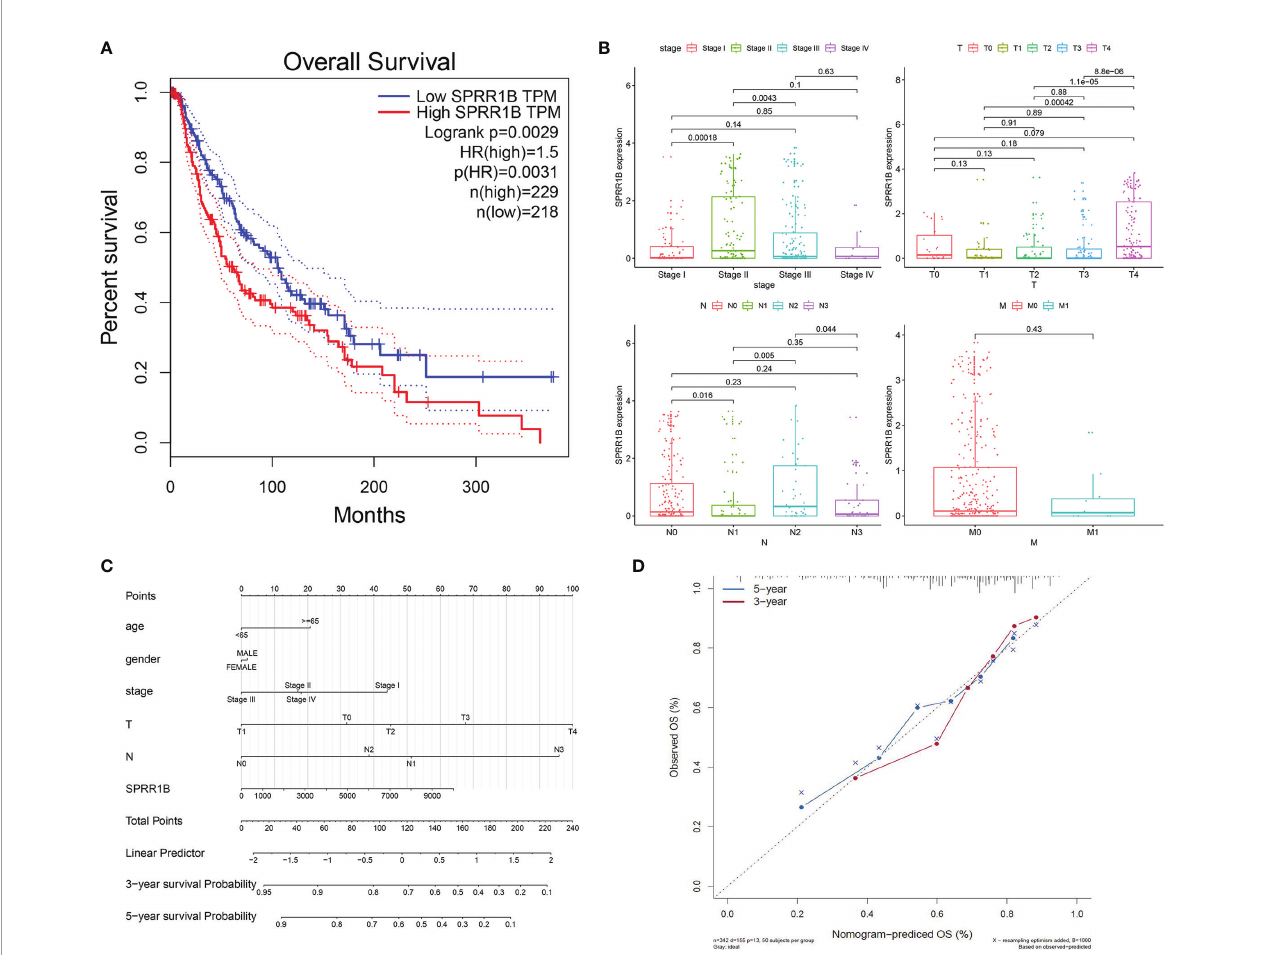
FIGURE 10 | (A) Survival analysis results of SPRR1b; (B) Clinical correlation analysis of SPRR1B; (C) Clinical prediction model of SPRR1B by histogram; (D) Veri fi cation of calibration curve of line chart prediction